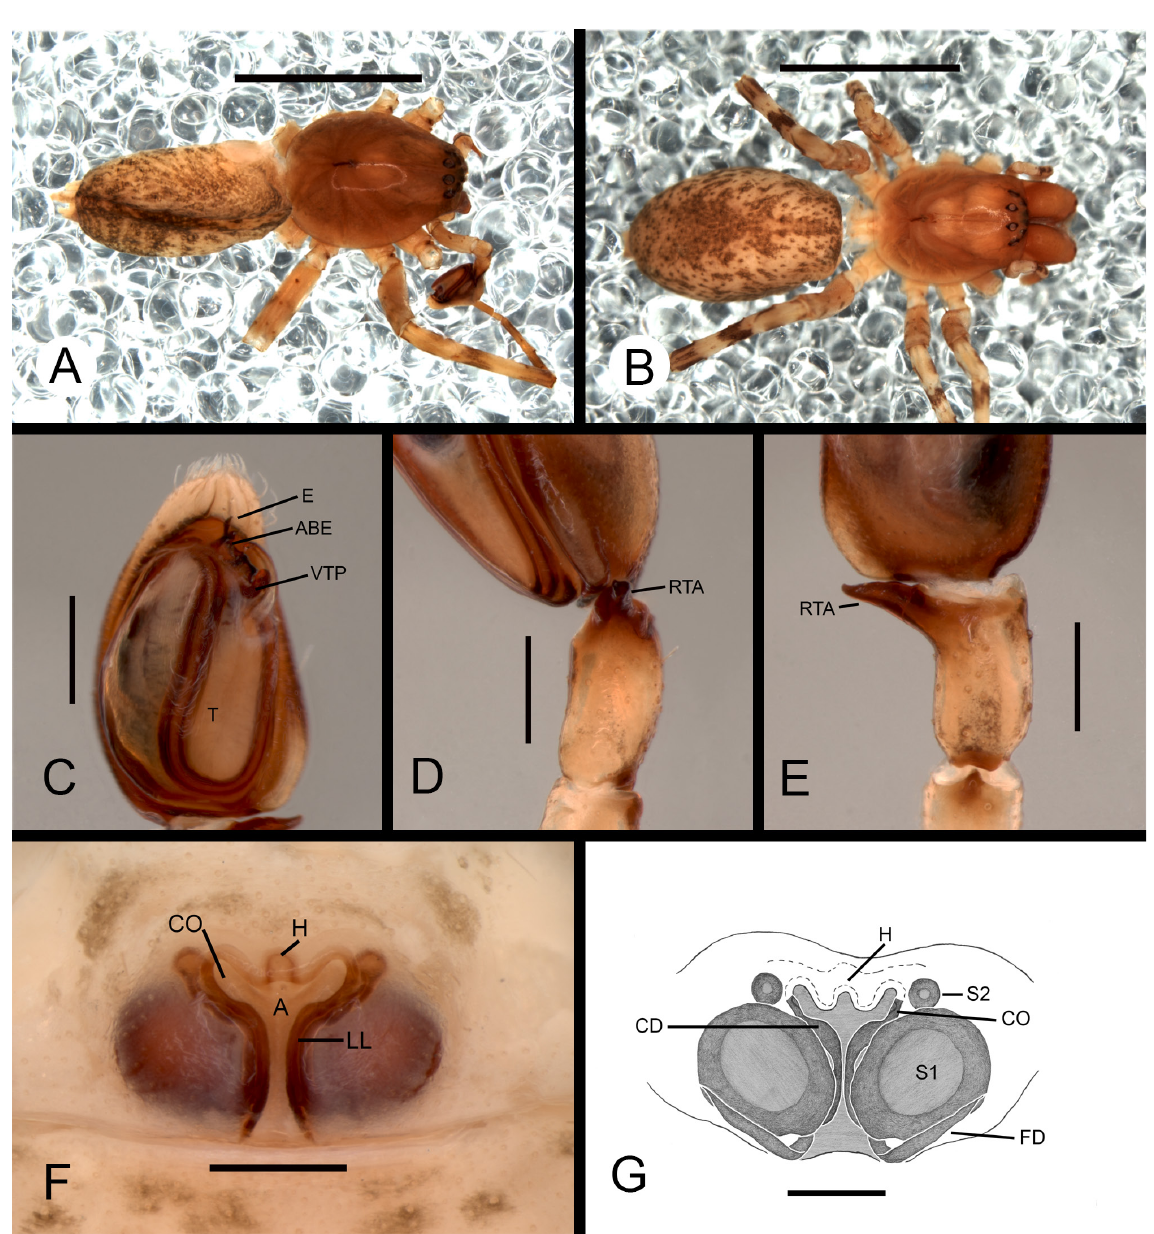
Fig. 15. Tafana humahuaca sp. nov. (A, C–E = holotype, ♂, MACN-Ar 41787; B, F–G = paratype, ♀, MACN-Ar 41788). A . Habitus, dorsal view. B . Habitus, dorsal view. C . Left palp, ventral view. D . Left palp, retrolateral view. E . Left palp, dorsal view. F . Epigynum, ventral view. G . Vulva, dorsal view. Abbreviations: A = atrium; ABE = apophysis of base of the embolus; CD = copulatory ducts; CO = copulatory opening; E = embolus; FD = fertilization ducts; H = hood; LL = lateral lobes; RTA = retrolateral tibial apophysis; S1 = primary spermathecae; S2 = secondary spermathecae; T = tegulum; VTP= ventral tegular process. Scale bars: A–B = 3.5 mm; C–G = 0.25